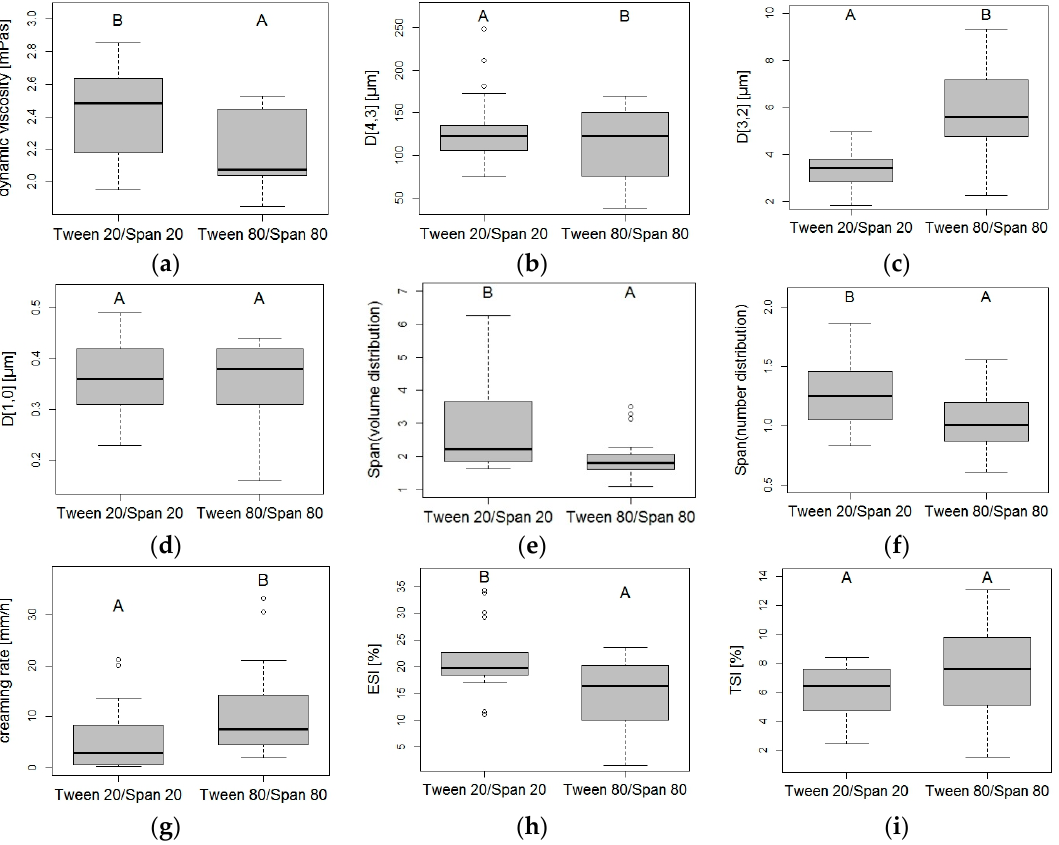
Figure 5. Effect of the surfactant blend on the ( a ) dynamic viscosity of the continuous phase, ( b ) volume-weighted moment mean diameter d 4,3 , ( c ) surface area mean diameter d 3,2 , ( d ) number mean diameter d 1,0 , ( e ) span of the volume distribution, ( f ) span of the number distribution; ( g ) flotation rate of the wax particles; ( h ) ESI, and ( i ) TSI. Note: Letters above represent post hoc test results, and different letters represent different statistical groups (analysis of variance or Kruskal–Wallis test, p < 0.05).